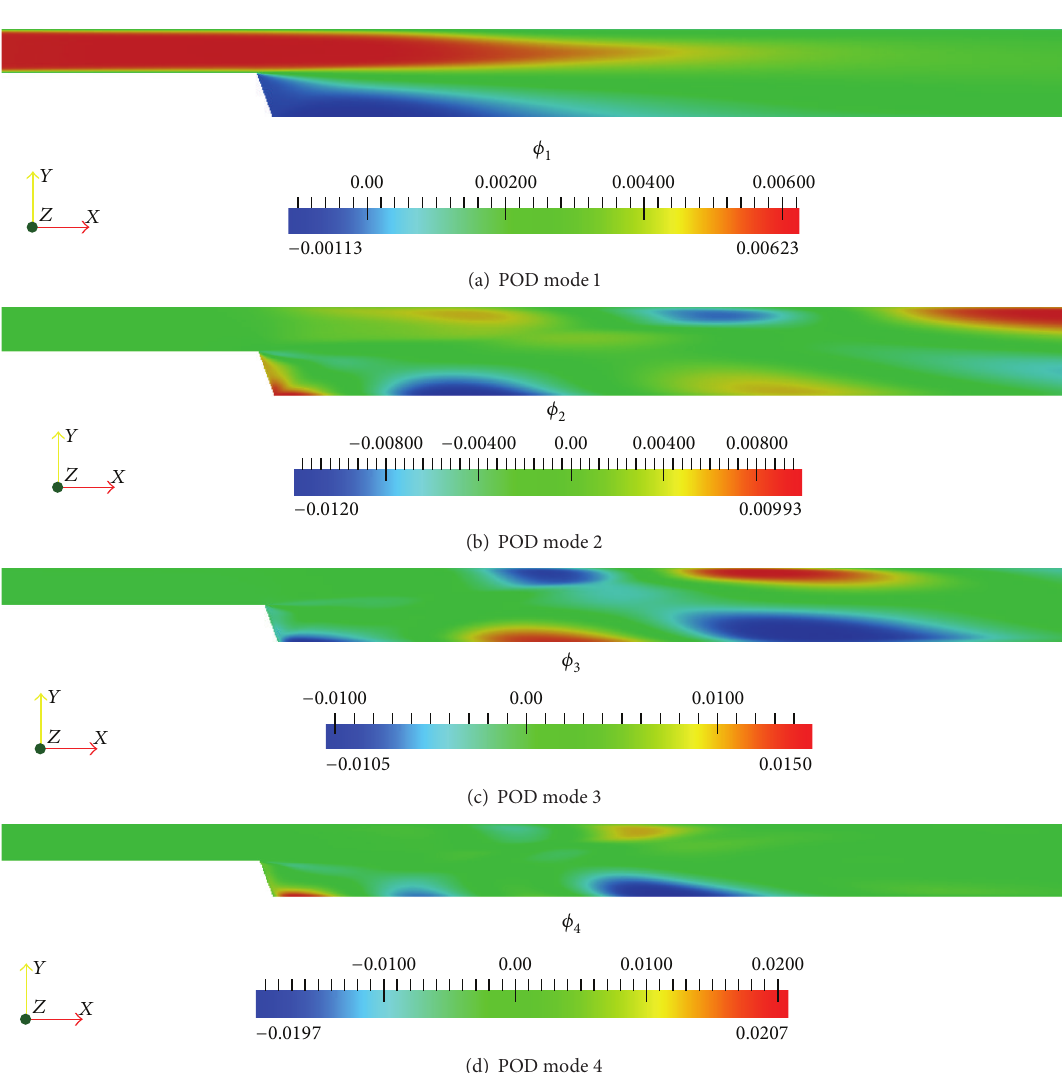
Figure 4: Backward facing step. POD modes for the velocity